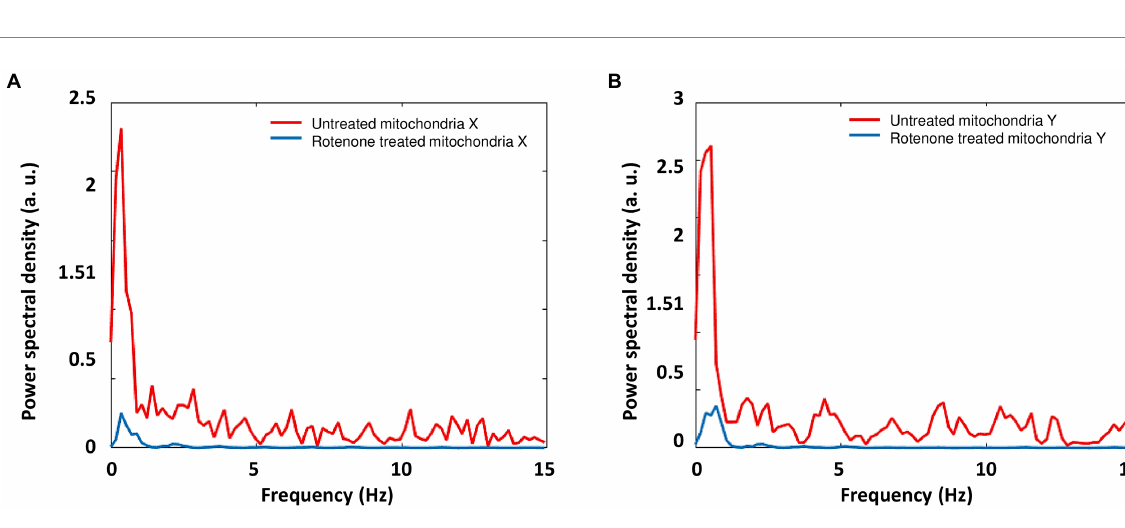
FIGURE 8 Mean PSD profiles for mitochondria ONMD signals in the X ( A ) and Y direction ( B ). Red: untreated mitochondria; Blue: rotenone treated